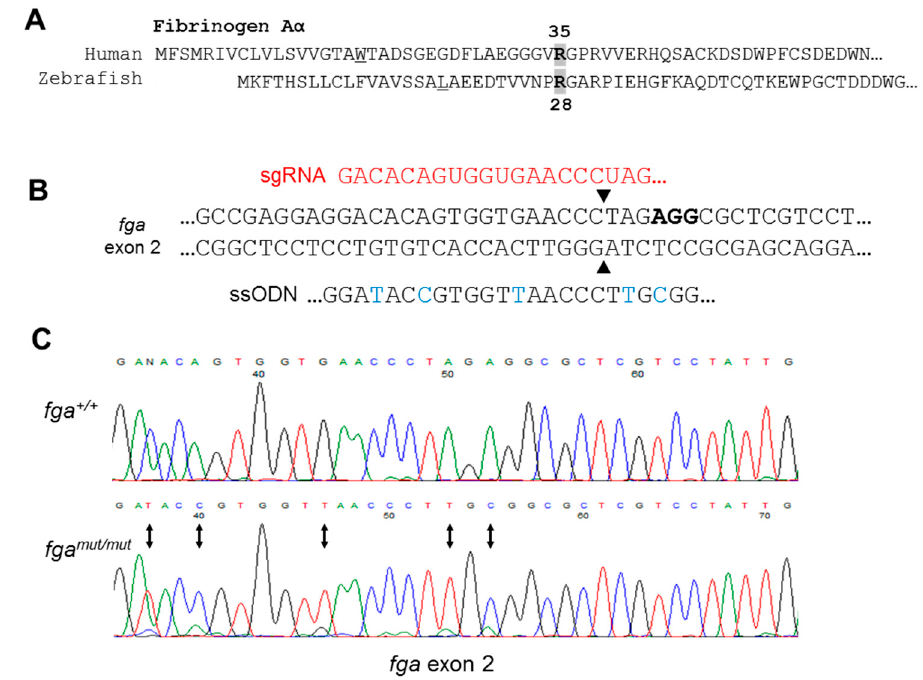
Figure 3. Genome editing of fga exon 2. ( A ) Aligned N-terminal region of human and zebrafish fibrinogen A α chains. A α R35 and A α R28 are indicated. ( B ) CRISPR/Cas9 strategy for fga exon 2 editing through homology directed repair (HDR). In red is part of the sgRNA targeting the edited region by complementarity, in bold is the PAM sequence. Part of the ssODN for HDR is shown to highlight edited nucleotides (blue), including codon usage changes and the Arg to Cys codon change. ( C ) Sanger sequencing to confirm genome edited sequence in genomic DNA from homozygous mutant fish ( fga mut/mut ), compared to wild-type ( fga +/+ ). Changed nucleotides are highlighted with arrows.